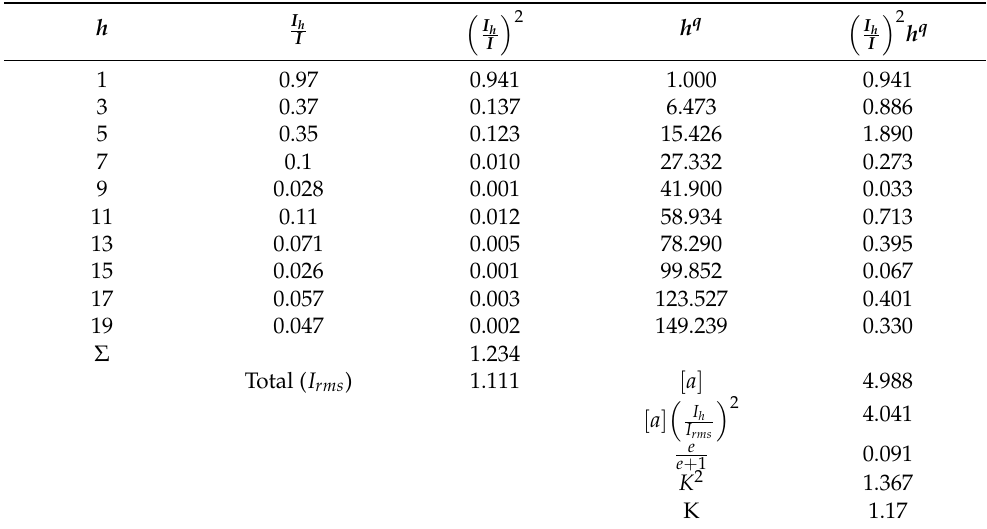
Table 14. Computation of the